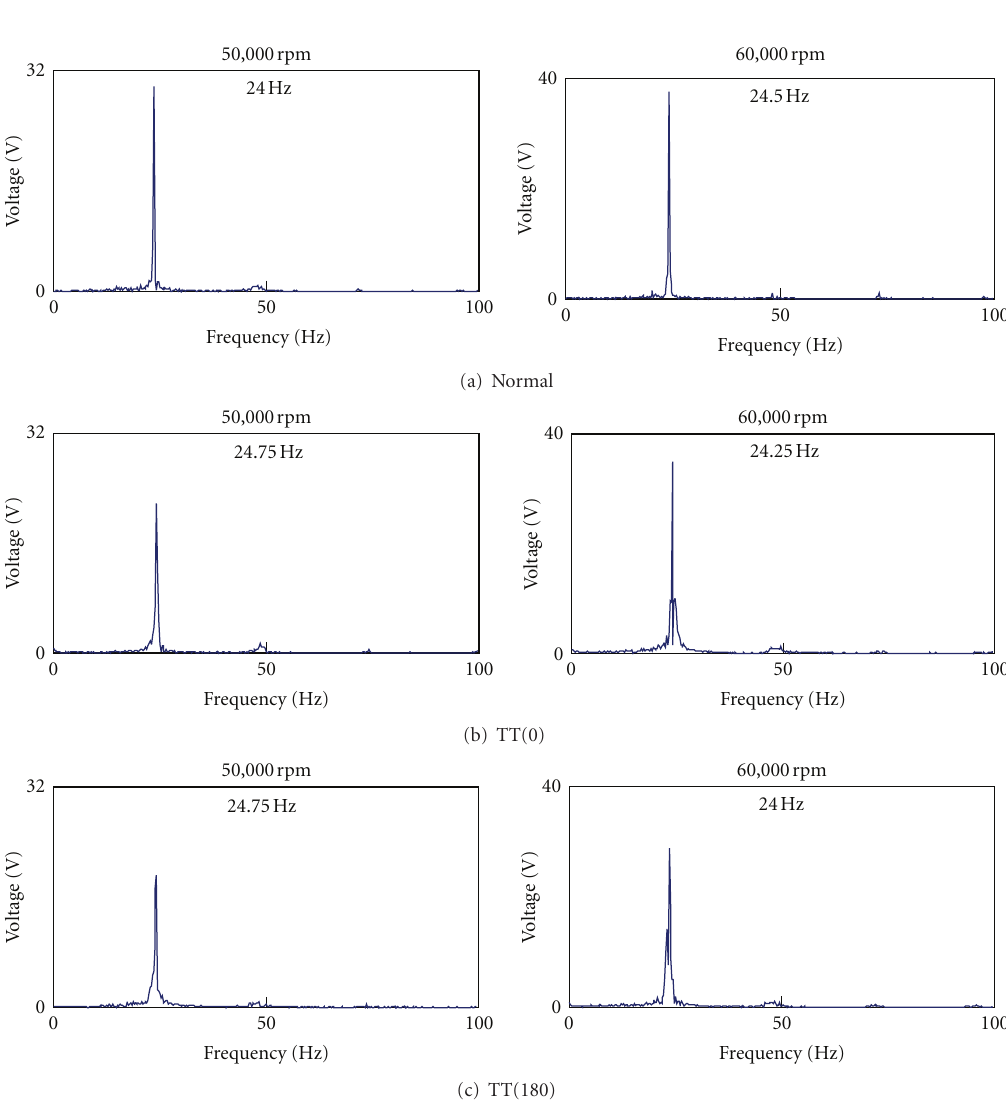
Figure 10: Spectrum of pressure fluctuation at delivery duct during surge for Type